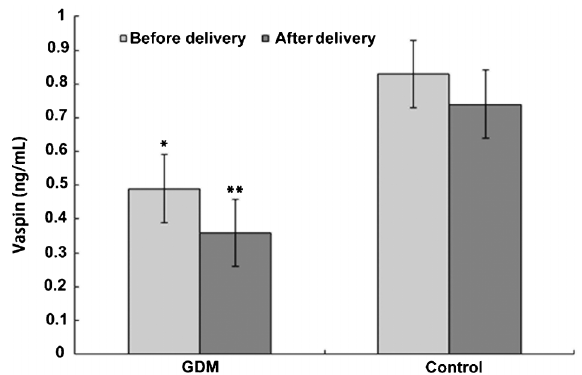
Figure 1. Median maternal serum vaspin concentrations in women with normal glucose tolerance (control) and gestational diabetes mellitus (GDM) at term (before delivery) and 3 days after delivery. *P , 0.01, compared to control before delivery; **P , 0.01, compared to before delivery (one-way ANOVA).